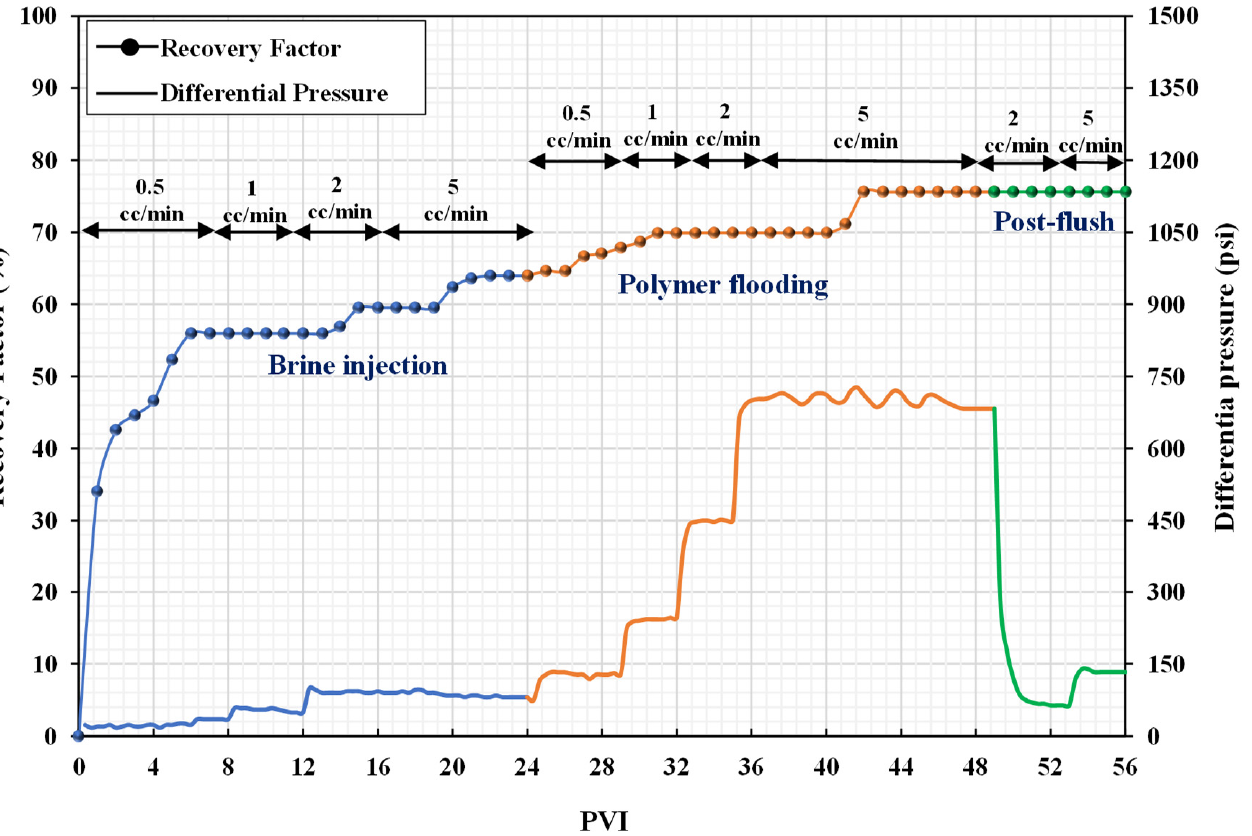
Figure 7. Recovery factors and differential pressure versus PVI (coreflood-1).